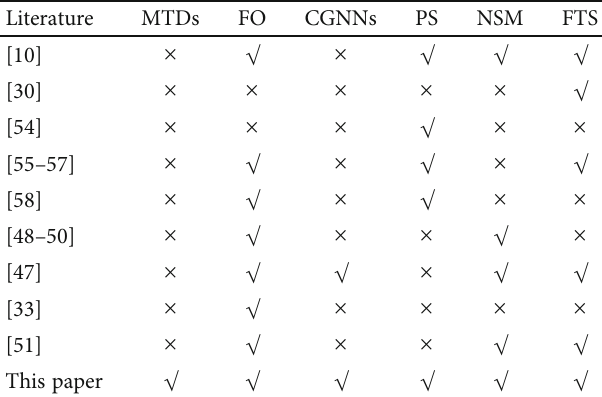
Table 1: Comparison with other